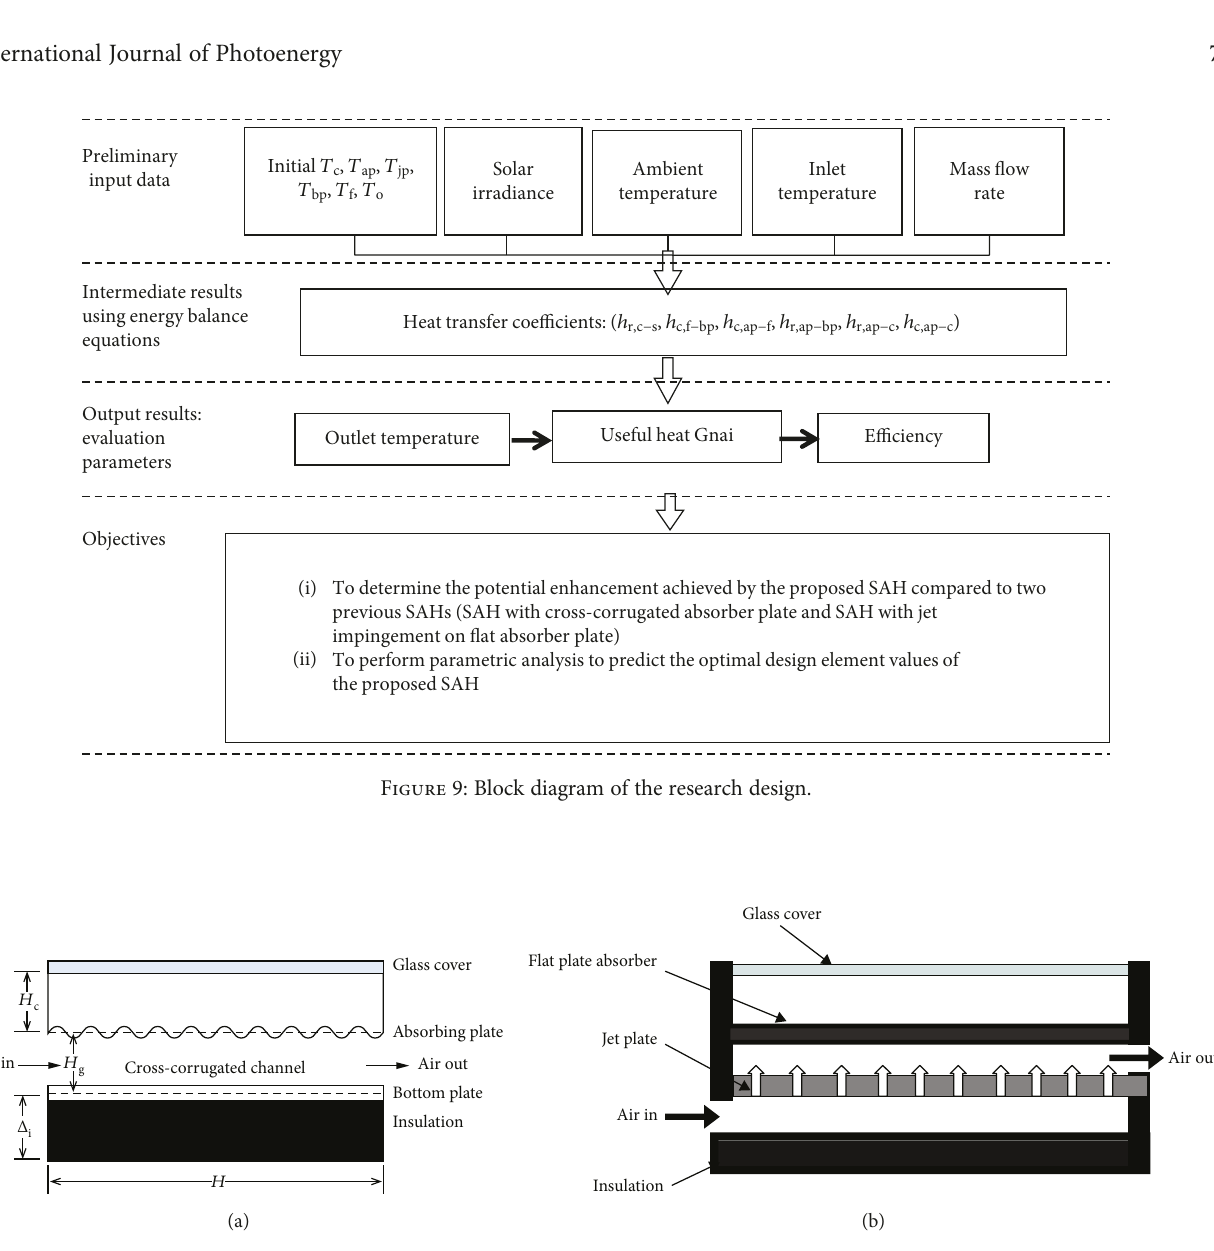
Figure 10: Schematic diagram of previous SAH designs (a) with a cross-corrugated absorber plate, Lin et al. [36] (b) with jet impingement on a fl at absorber plate, Choudhury and Garg [37].